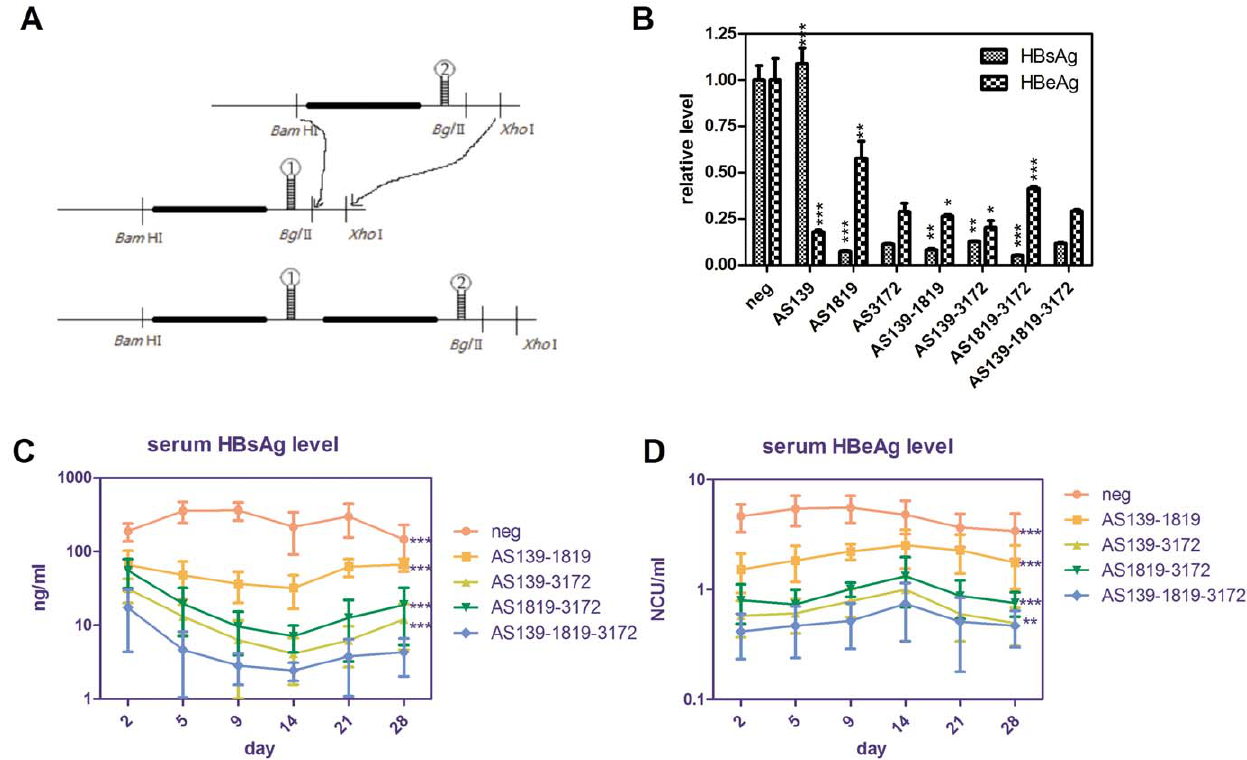
Figure 6. Efficient down regulation of HBsAg and HBeAg expression using linked shRNAs concatemers both invitro and invivo . (A) The diagram illustrates the principle of chaining two shRNAs derived from two different shRNA vectors into one vector. (B) HepG2 cells were seeded in 24-well plates and cotransfected with 200 ng of pHBV1.31, 200 ng shRNA plasmid and 100 ng pSEAP2-Control (as a normalization control) per well. After 48 h, the HBsAg and HBeAg concentrations were determined. Means and standard deviations were generated from 3 independent experiments. (C) Serum HBsAg and (D) HBeAg were measured by quantitative ELISA at the indicated days after plasmids delivery. Groups of male C57/BL6 mice (n=6) were intravenously injected with 6 m g pHBV1.18, 3 m g shRNA plasmids and 3 m g pSEAP2-Control (as an internal control). NCU is the abbreviation of ‘‘National Clinical Unit’’. Statistical significance was determined respectively by comparing shRNAs groups with AS139-1819-3172. Due to limited serum resources, each sample was diluted 20-fold.